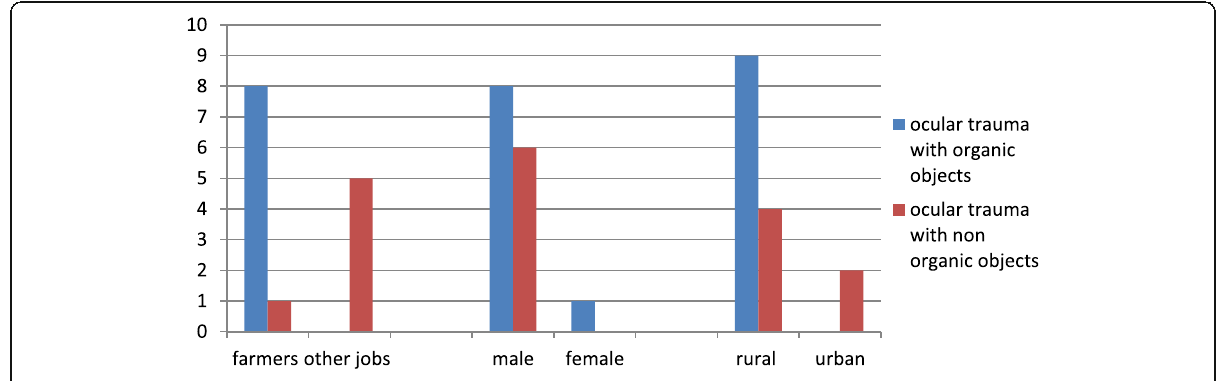
Fig. 2 Ocular trauma with organic and non-organic objects according to sex, occupation, and